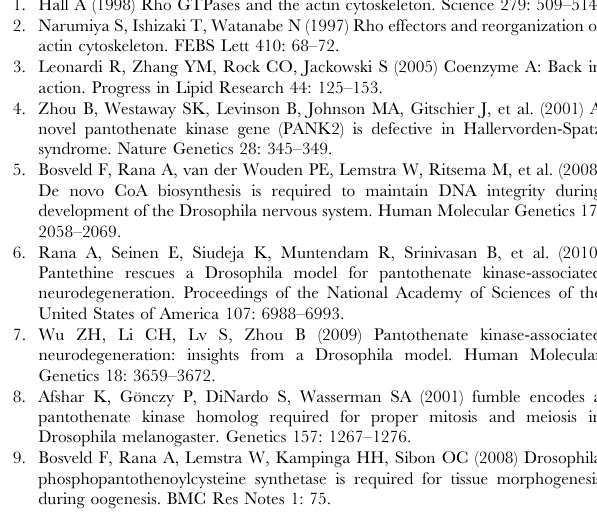
imaged during cell spreading and lamella formation in phase contrast as described under Figure S4. under Figure S4. Table S1 Primers used for RNAi constructs. The following primers were used to generate dsRNAs. 5 9 T7 RNA polymerase binding site (TAATACGACTCACTATAGGG) was proceeding each primer’s